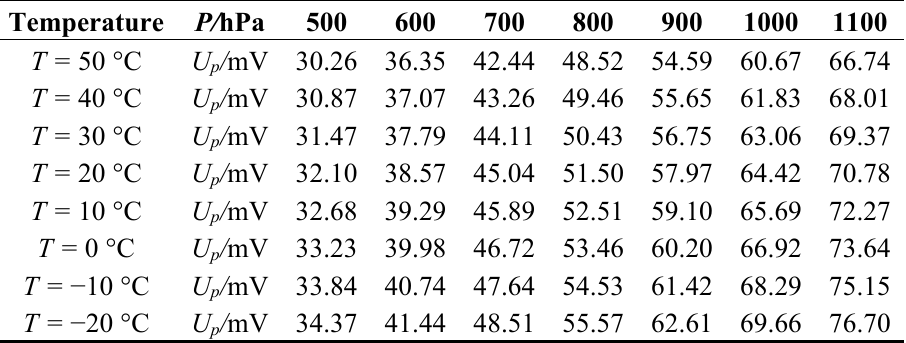
Table 1. The calibration sample data of the MEMS-array pressure sensors for the training of the genetic algorithm-wavelet neural network (GA-WNN), which are obtained with pressures from 500 to 1100 hPa and with temperatures from − 20 to 50